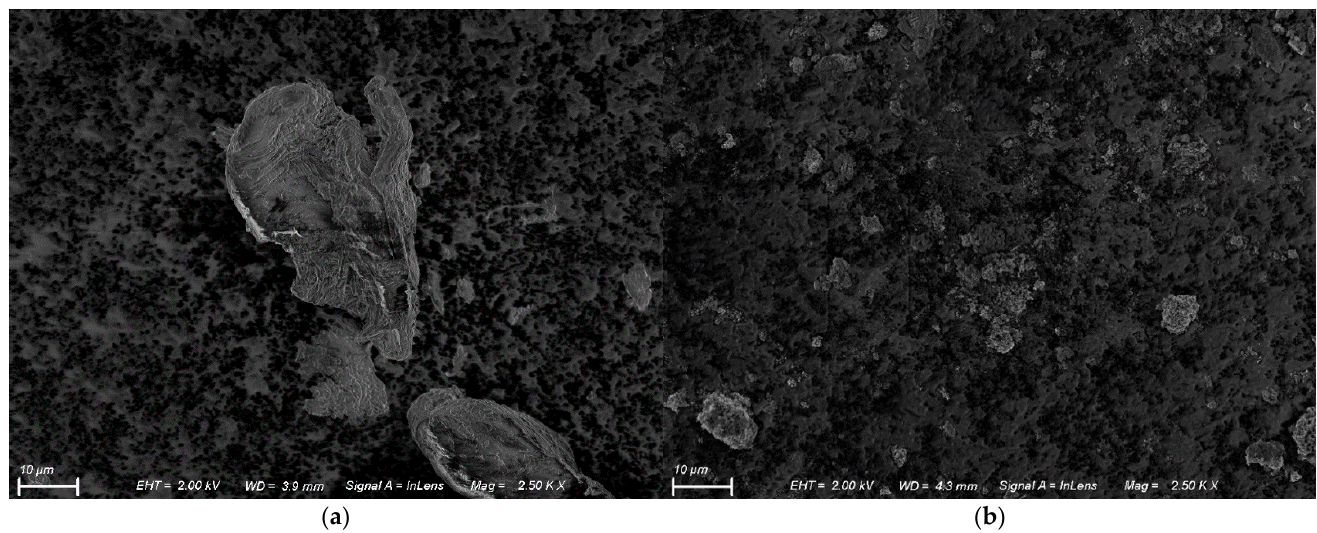
Figure 4. SEM images of biopolymers with 2.5 KX magnification: ( a ) chitosan and ( b ) magnetic chi- tosan.